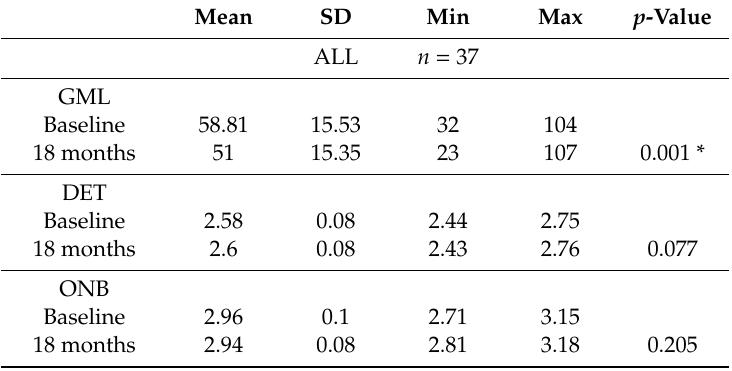
Table 10. Mean di ff erence scores at baseline and 18 months across the CogState battery for all participants and stratified by